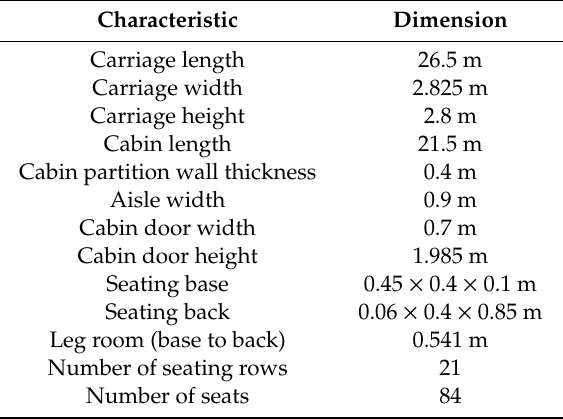
Table 1. Model’s dimensional characteristics.